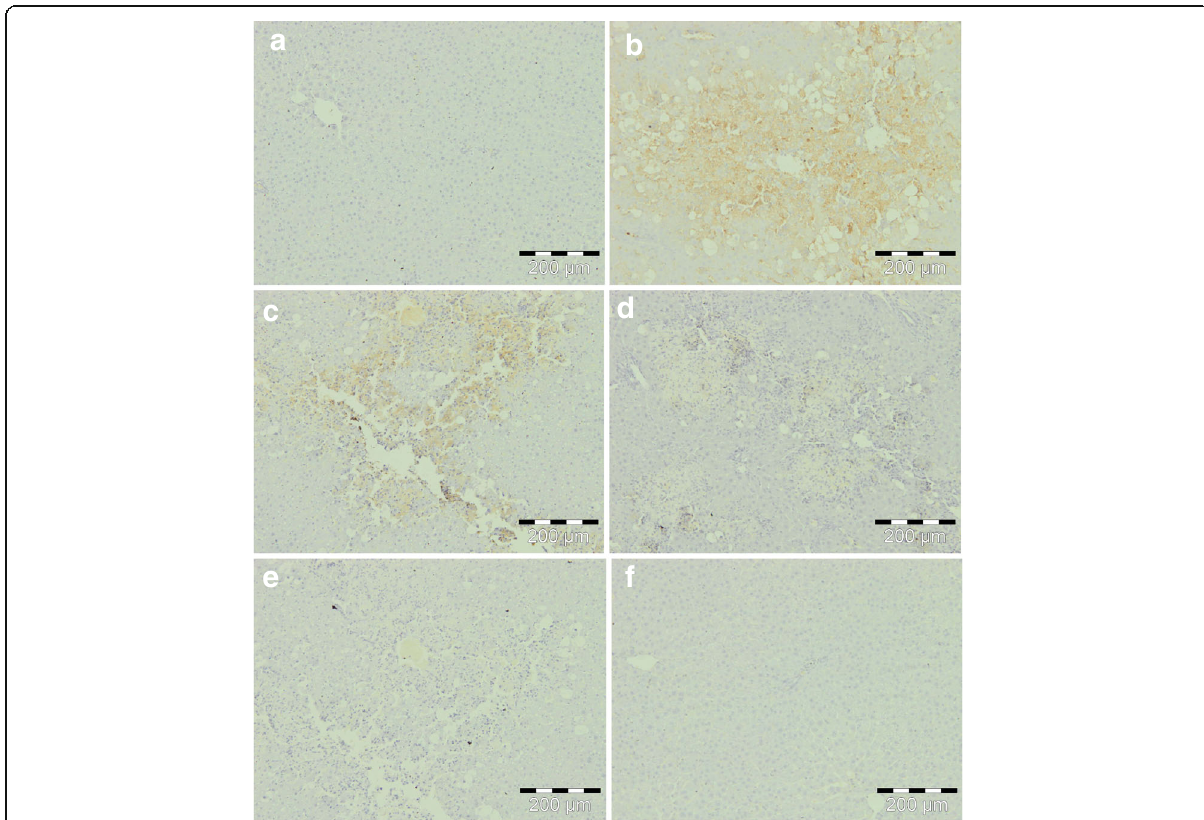
Fig. 9 Immunohistochemical appearance of 8-OHdG. a Control group, normal. b CCl 4 (1 ml/kg b.wt.), increased formation of 8-OHdG. c C. nudiflora (150 mg/kg b.wt. + CCl 4 ), decreased formation of 8-OHdG. d C. nudiflora (300 mg/kg b.wt. + CCl 4 ), decreased formation of 8-OHdG. e C. nudiflora (450 mg/kg b.wt. + CCl 4 ), decreased formation of 8-OHdG. f C. nudiflora alone (450 mg/kg b.wt.),